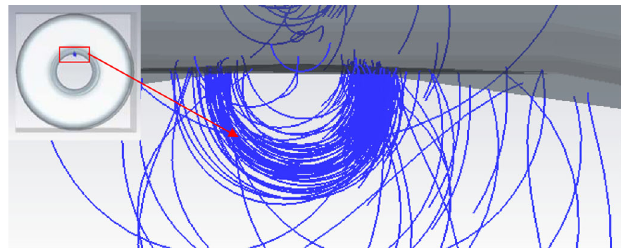
FIG. 14. Electron trajectories from CST PARTICLE STUDIO . The left inset shows the position of the multipactor on the iris.